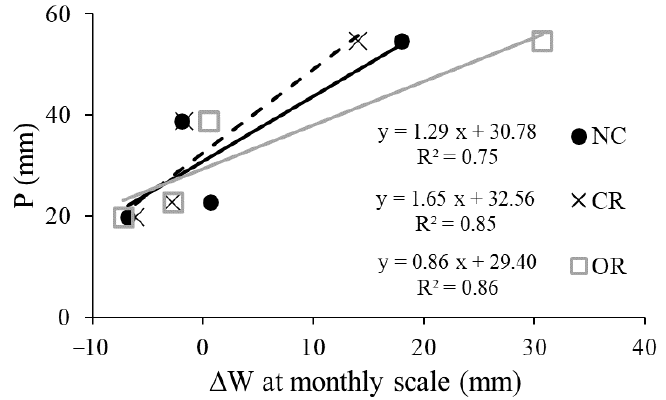
Figure 9. Responses of ∆ W to precipitation under different treatments at the monthly scale. P: precipitation, ∆ W : the change in soil water storage.